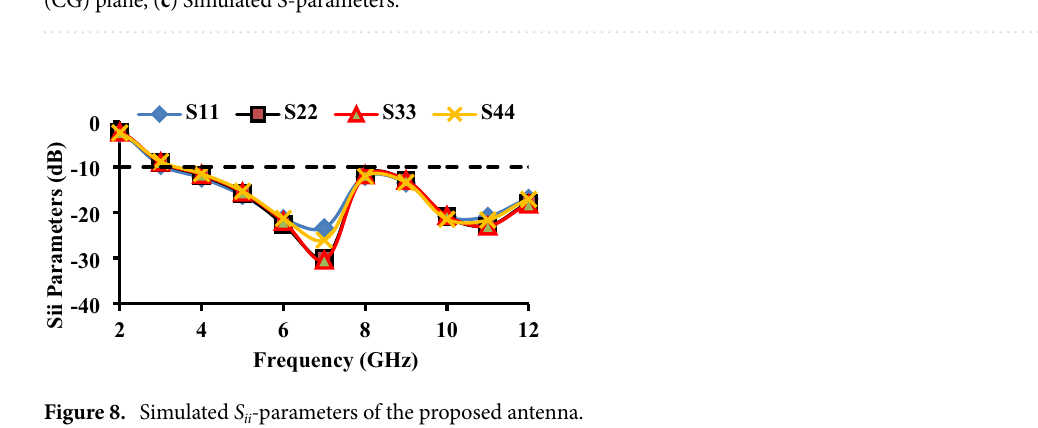
Figure 8. Simulated S ii - parameters of the proposed